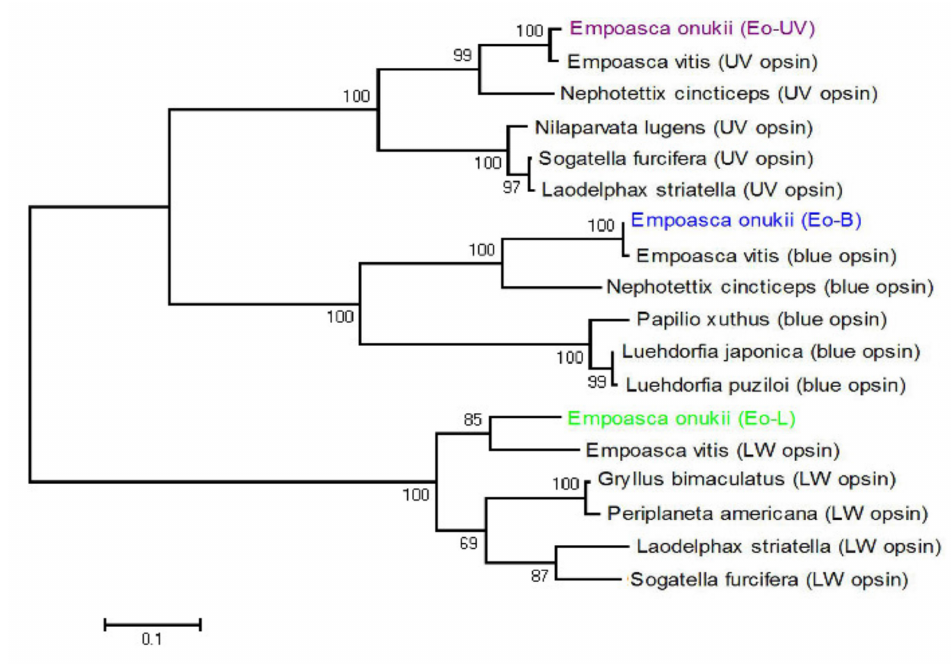
Figure 2. Phylogenetic relationships among three types of opsin from 10 species: Empoasca onukii express three types of opsin, ultraviolet (UV), blue (B), and long wavelength (LW) absorbing opsins, colored in violet ( Eo -UV, short wavelength clade), blue ( Eo -B, middle-wavelength clade), and green ( Eo -L, long-wavelength clade),